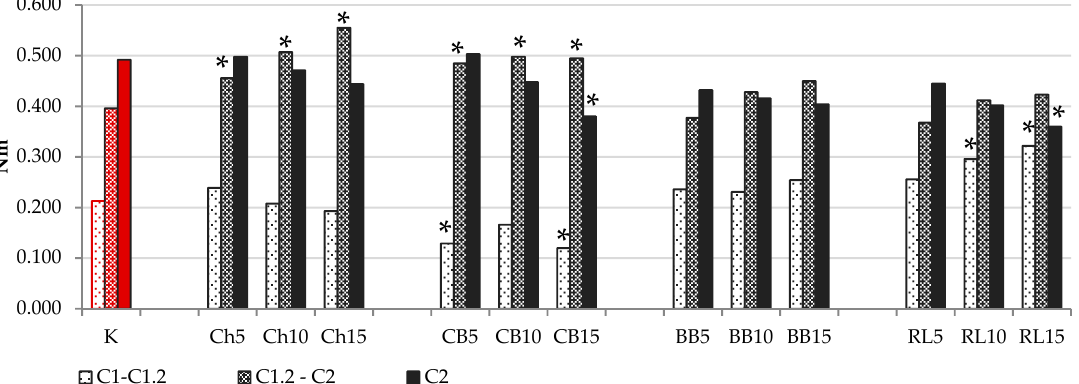
Figure 1. C2 Minimum consistency (Nm). [C1–C1.2] Weakening based on mechanical work at 30 °C. [C1.2–C2] Protein weakening based on temperature increase. * values are significantly different ( p < 0.05) compared to control. K = WF(50) + RF(50); Ch5 = WF(50) + RF(45) + ChF(5); Ch10 = WF(50) + RF(40) + ChF(10); Ch15 = WF(50) + RF(35) + ChF(15); CB5 = WF(50) + RF(45) + CBF(5); CB10 = WF(50) + RF(40) + CBF(10); CB15 = WF(50) + RF(35) + CBF(15); BB5 = WF(50) + RF(45) + BBF(5); BB10 = WF(50) + RF(40) + BBF(10); BB15 = WF(50) + RF(35) + BBF(15); RL5 = WF(50) + RF(45) + RLF(5); RL10 = WF(50) + RF(40) + RLF(10); RL15 = WF(50) + RF(35) + RLF(15).